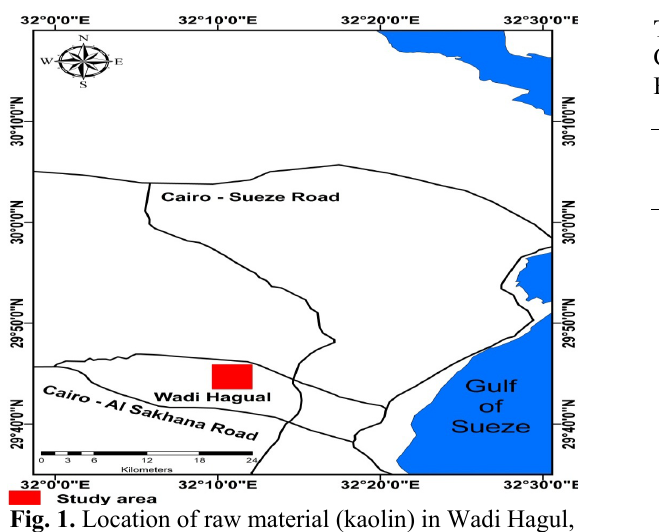
Fig. 1. Location of raw material (kaolin) in Wadi Hagul, Suez,